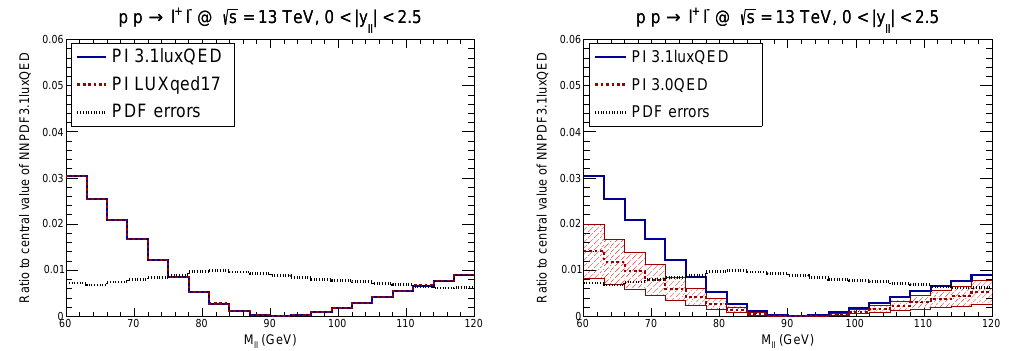
Figure 4.2: The ratio of photon-initiated contributions to the corresponding quark- and gluon-initiated ones for neutral current Drell-Yan production as function of the lepton-pair invariant mass M in the Z peak region and central rapidities | y ll We compare NNPDF3.0QED, LUXqed17, and NNPDF3.1luxQED, with the PI contributions in each case normalized to the central value of the latter. The NNPDF3.0QED uncertainty band is represented by the red band. For reference, we also indicate the value of the PDF uncertainties in